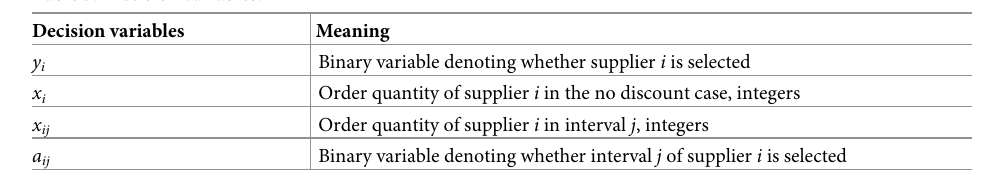
Table 3. Decision